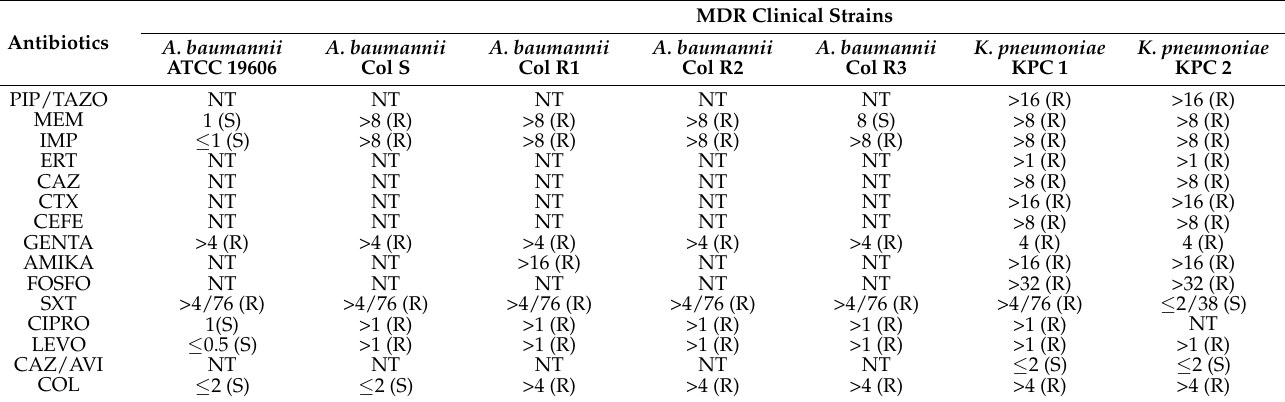
Table 3. Antibiotic susceptibility profiles of strains used in the study.